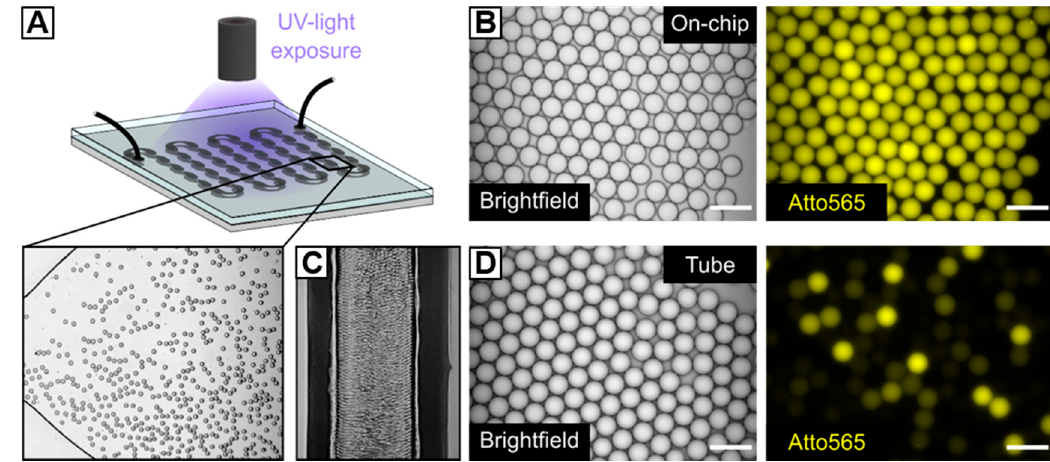
Figure 3. Microfluidic fabrication of HASH-microgels. ( A ) Schematic depiction of a microfluidic chamber for UV-initiated in situ crosslinking of HASH-based W / O emulsion droplets under continuous flow and corresponding brightfield image. ( B , D ) Brightfield images and fluorescence microscopy images (Atto565) of W / O emulsion droplets after UV-irradiation (B) within the microfluidic on-chip UV-chamber with a height of 50 µ m and (D) within the microfluidic outflow tubing of the flow-focusing device. ( C ) Densely packed W / O emulsion inside the outflow tubing of the flow-focusing device. The scale bars denote 50 µ m. The experimental microscope setup for the on-chip UV-polymerization of HASH-based W / O emulsions is depicted in Figure S1.